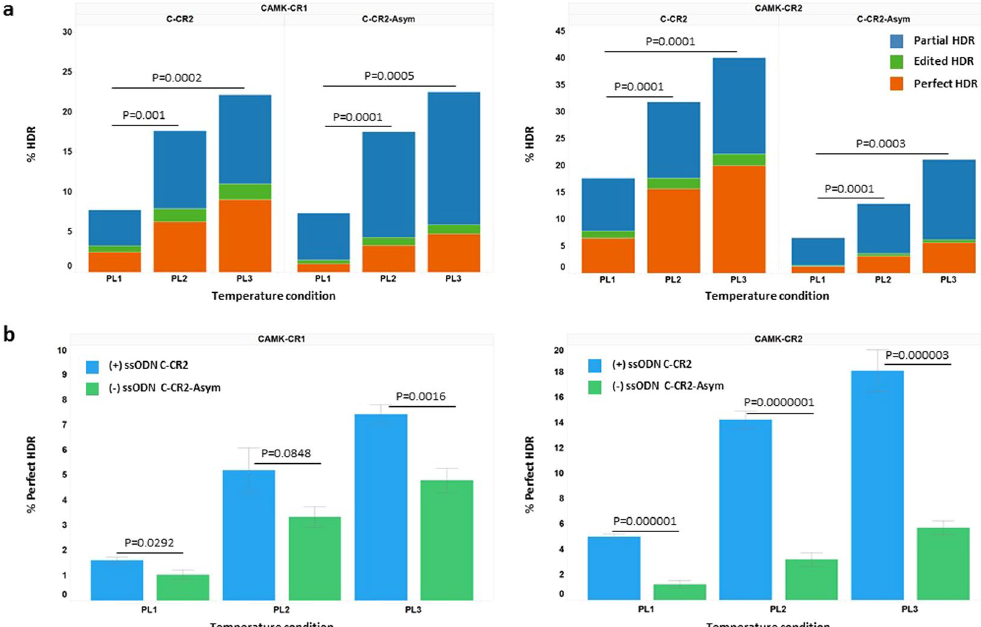
Figure 3. Effects of ‘cold shock’ and ssODN HDR donor designs on HDR efficiencies at the CAMK2D locus in mc-iPSCs as determined by NGS. Various amounts of ssODN C-CR2 or C-CR2-Asym were delivered to mc-iPSCs along with Cas9 mRNA and sgRNA CAMK-CR1 or CAMK-CR2 to achieve HDR at the CAMK2D locus. The experiments were carried out at different temperatures over 24 hour intervals as described in “material and methods”: PL1: 37 °C-37 °C-37 °C, PL2: 37 °C-32 °C-37 °C, PL3: 37 °C-32 °C-32 °C. ( a ) HDR events using 10 pmol of ssODN HDR donors for each treatment (CAMK-CR1 with C-TR2 or C-TR2-Asym, CAMK-CR2 with C-TR2 or C-TR2-Asym) were determined by NGS as described in “material and methods”. The data presented are the mean percent HDR events (C-CR2: 8 biological replicates from three